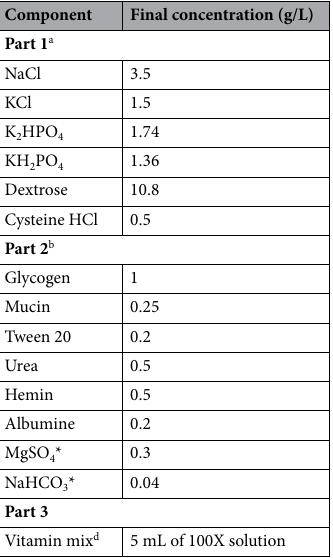
Table 1. Composition of the simulating genital tract secretion (SGTS) medium. *Solutions were sterilized by passage through a membrane filter (pore size, 0.22 µm). a Prepared by dissolving the components in pure 18.2 MΩ water. After adjustment of the pH to 7.2 with NaOH, the solution was autoclaved for 15 min at 121 °C and then cooled to room temperature. b Part 2 consisted of eight components prepared separately. Components 1 to 5 were prepared as concentrated solutions and autoclaved for 15 min at 121 °C.